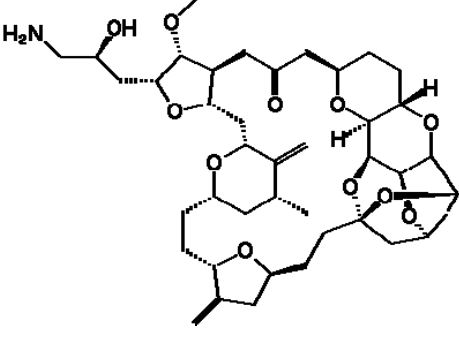
Figure 1. Chemical structure of eribulin.